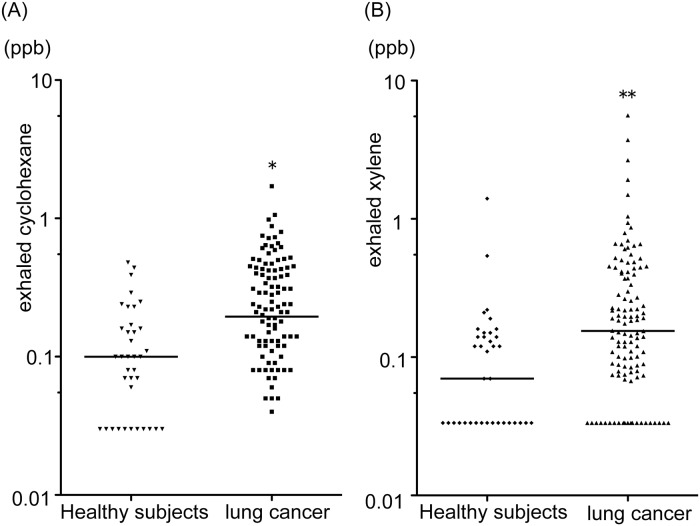
Exhaled cyclohexane (A) and xylene (B) concentrations in healthy subjects and patients with lung cancer.The horizontal lines indicate the median values. *p = 0.002, **p = 0.0001 versus healthy subjects.